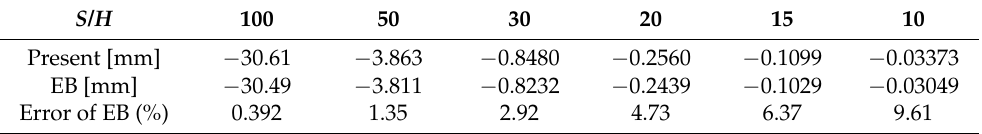
Table 3. Comparisons of the mid-span deflection among the present and EB solution when t = 10 10 s at different ratios S / H .